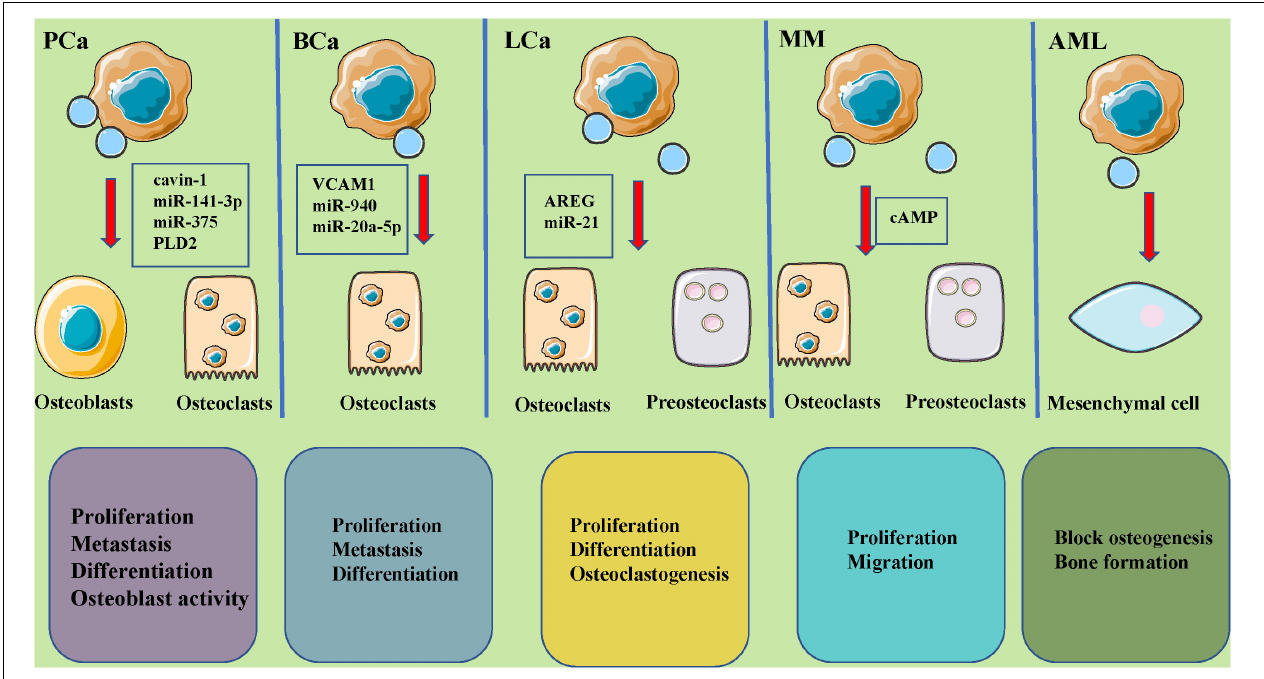
FIGURE 3 | The roles of tumor-derived extracellular vesicles in bone metastases and potential molecular mechanisms. EVs, secreted by PCa (cavin-1, miR-142-3p, miR-375, PLD2), BCa (VCAM1, miR-940, miR-20a-5p), LCa (AREG, miR-21), MM (cAMP), and AML tumors could carry different and abundant content and play a key role in osteoclastic and osteoblastic cycling, leading to various metastatic lesions. PCa, prostate cancer; BCa, breast cancer; LCa, lung cancer; MM, multiple myeloma; AML, acute myelocytic leukemia; TGFB2, transforming growth factor beta 2; AXL, AXL receptor tyrosine kinase; PLD2, phospholipase D2; VCAM1, vascular cell adhesion molecule 1; AREG,